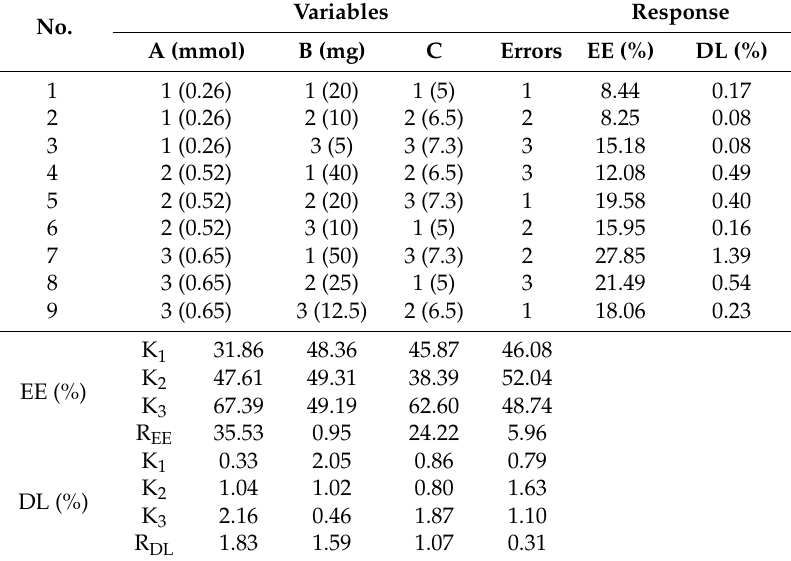
Table 2. Experimental design and measured